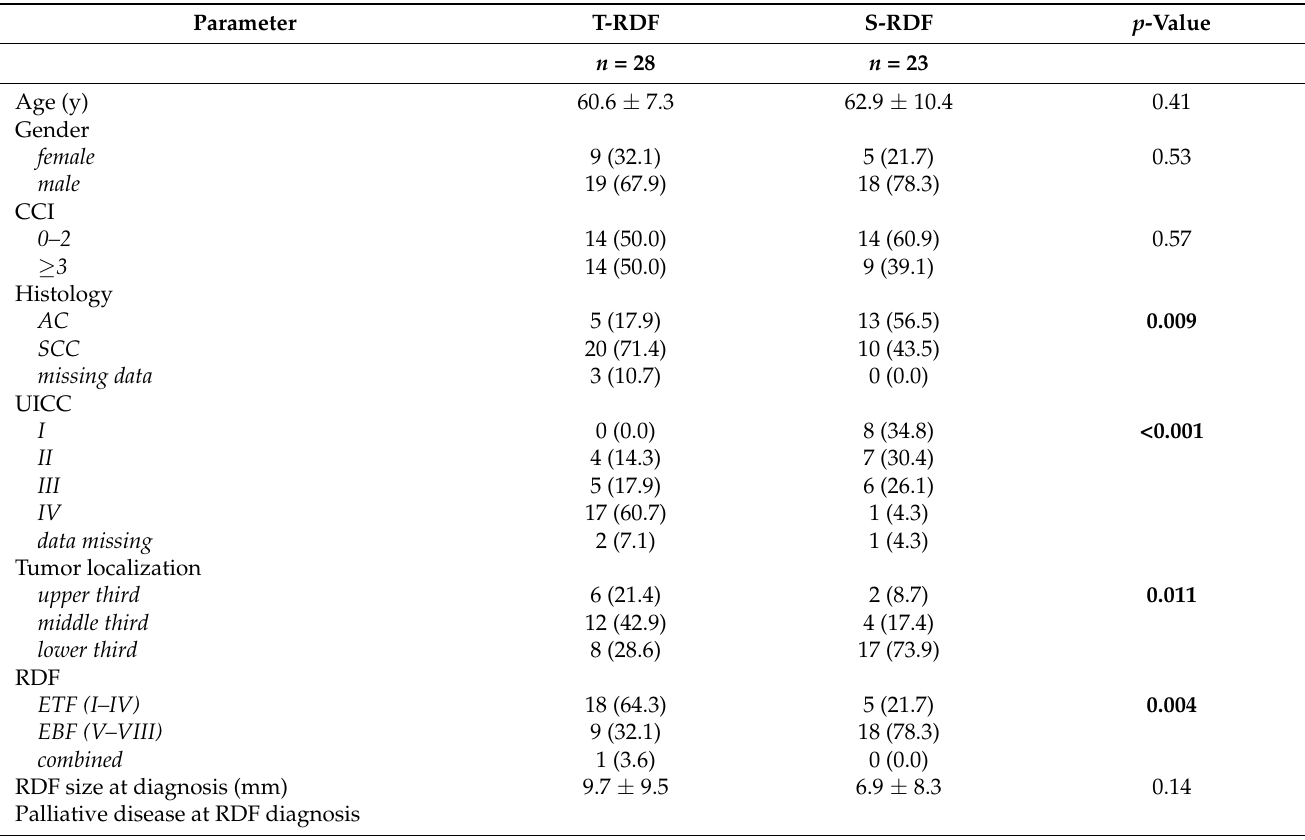
Table 1. Demographic, clinicopathological, and RDF